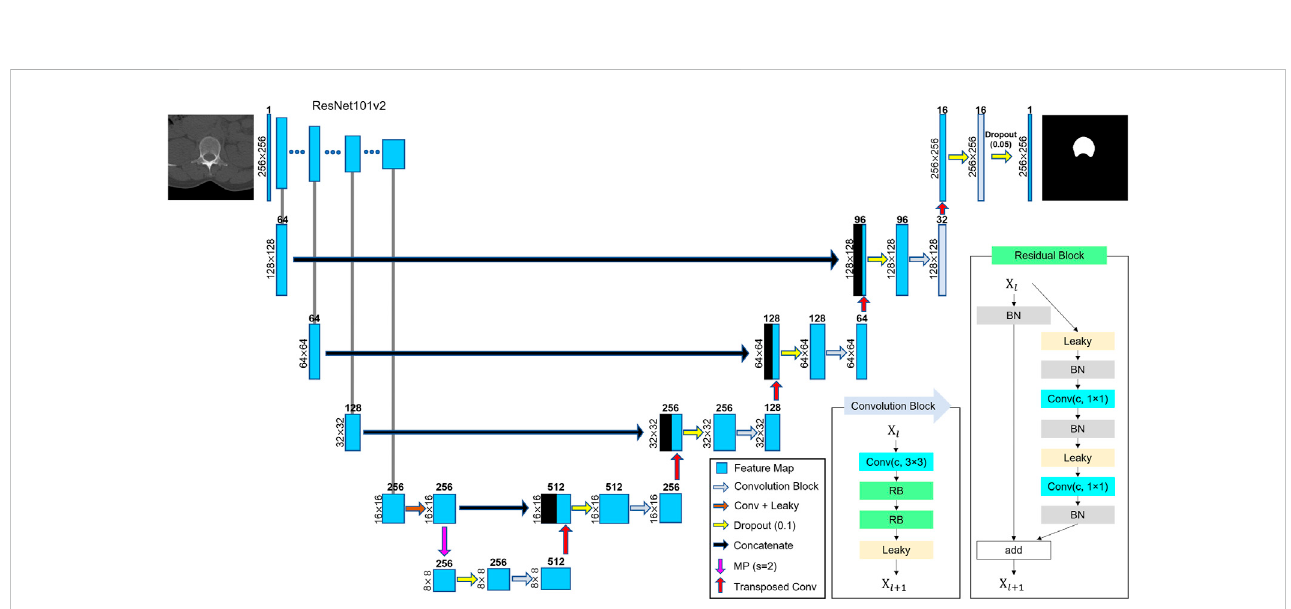
FIGURE 2 Schematic of U-Net structure. ResNet-101v2 was used as the backbone network. The number on the left of every box represents the size of image or feature map. The number above the box denotes the number of feature maps (channels). A dropout was applied before every convolutional block for generalization. Arrows represent the operators. The meanings of the abbreviations are as follows: Conv, convolutional layer; RB, residual block; Leaky, leaky ReLU ( α = .1); BN, batch normalization; MP, max-pooling layer; s, strides, and c, channel of convolutional